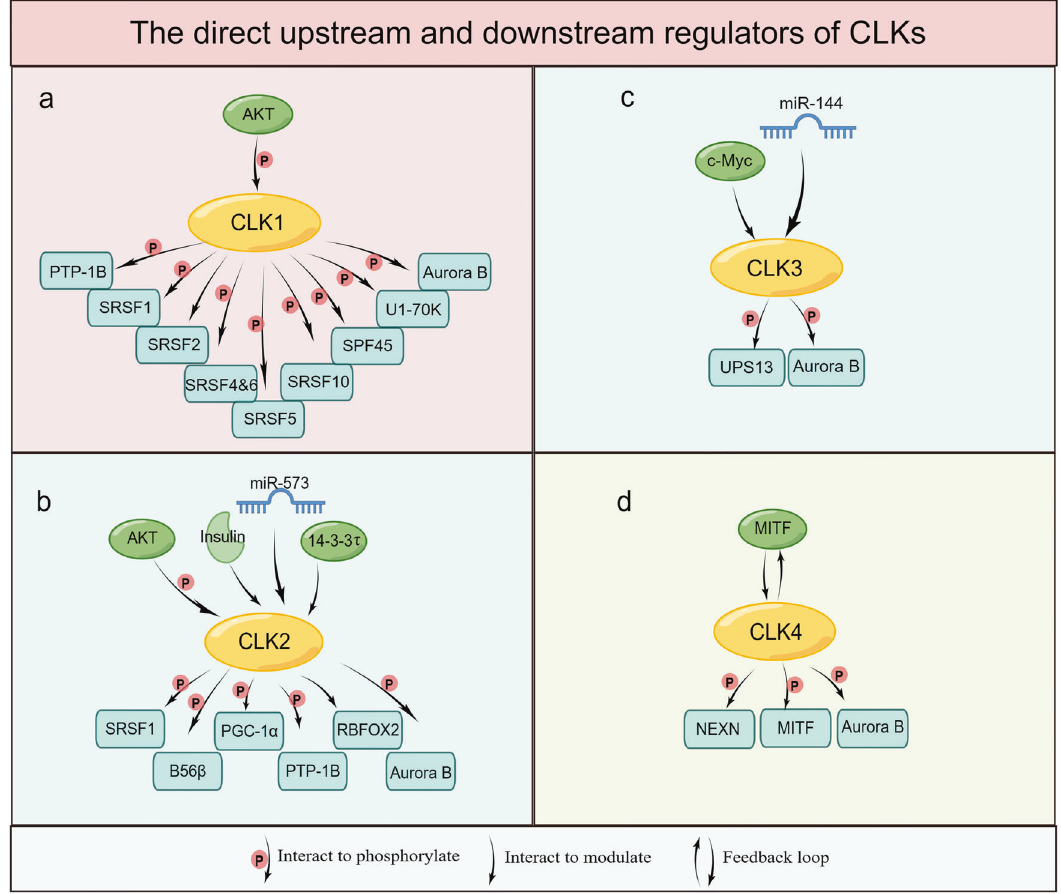
Fig. 3 The direct upstream and downstream regulators of CLKs. The expression or activities of CLKs are directly regulated by the upstream proteins such as AKT, c-Myc, or miRNAs. CLKs phosphorylate or modulate their downstream targets, which have been demonstrated in publications, to participate in pivotal processes. The upstream and downstream regulators of CLK1 ( a ), CLK2 ( b ), CLK3 ( c ), and CLK4 ( d ) have been shown in the fi gure seperately. The fi gure was generated by Figdraw (www. fi